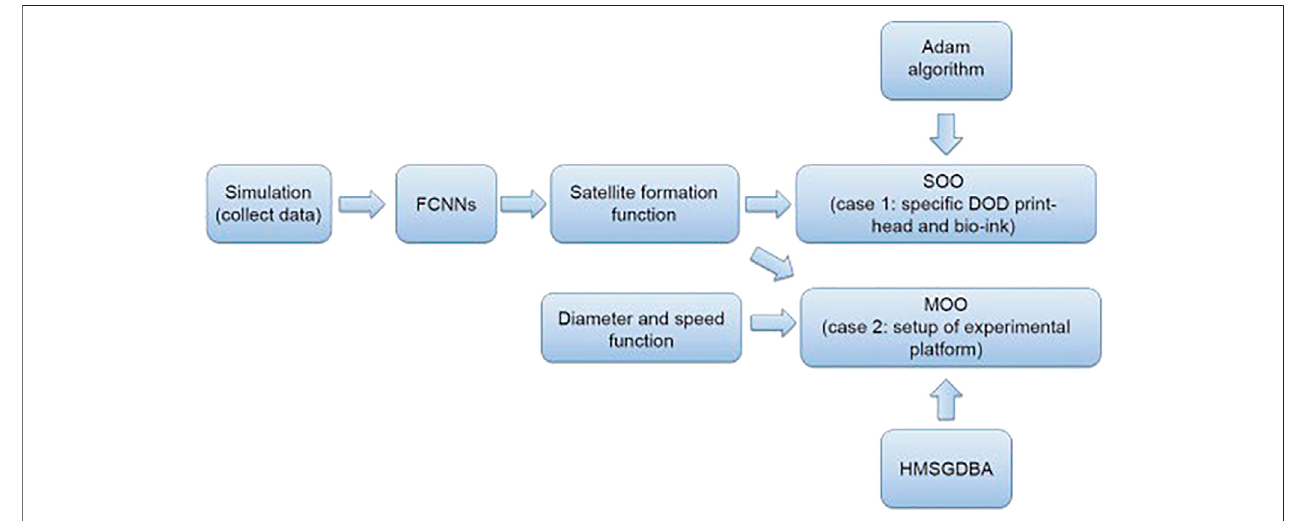
FIGURE 3 | Flowchart depicting schematics of multi-objective optimization design for improved drop-on-demand bioprinting (Shi et al., 2019).